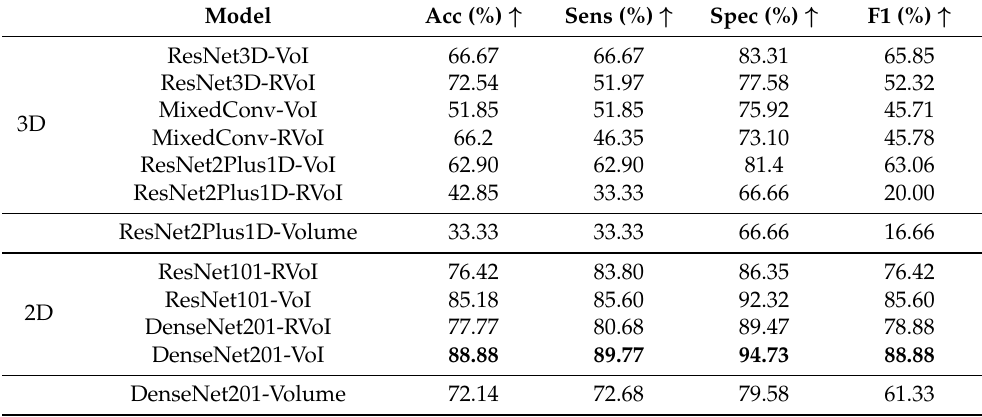
Table 5. Ablation results on HUMC19-CT US test set. Best results are highlighted with bold .